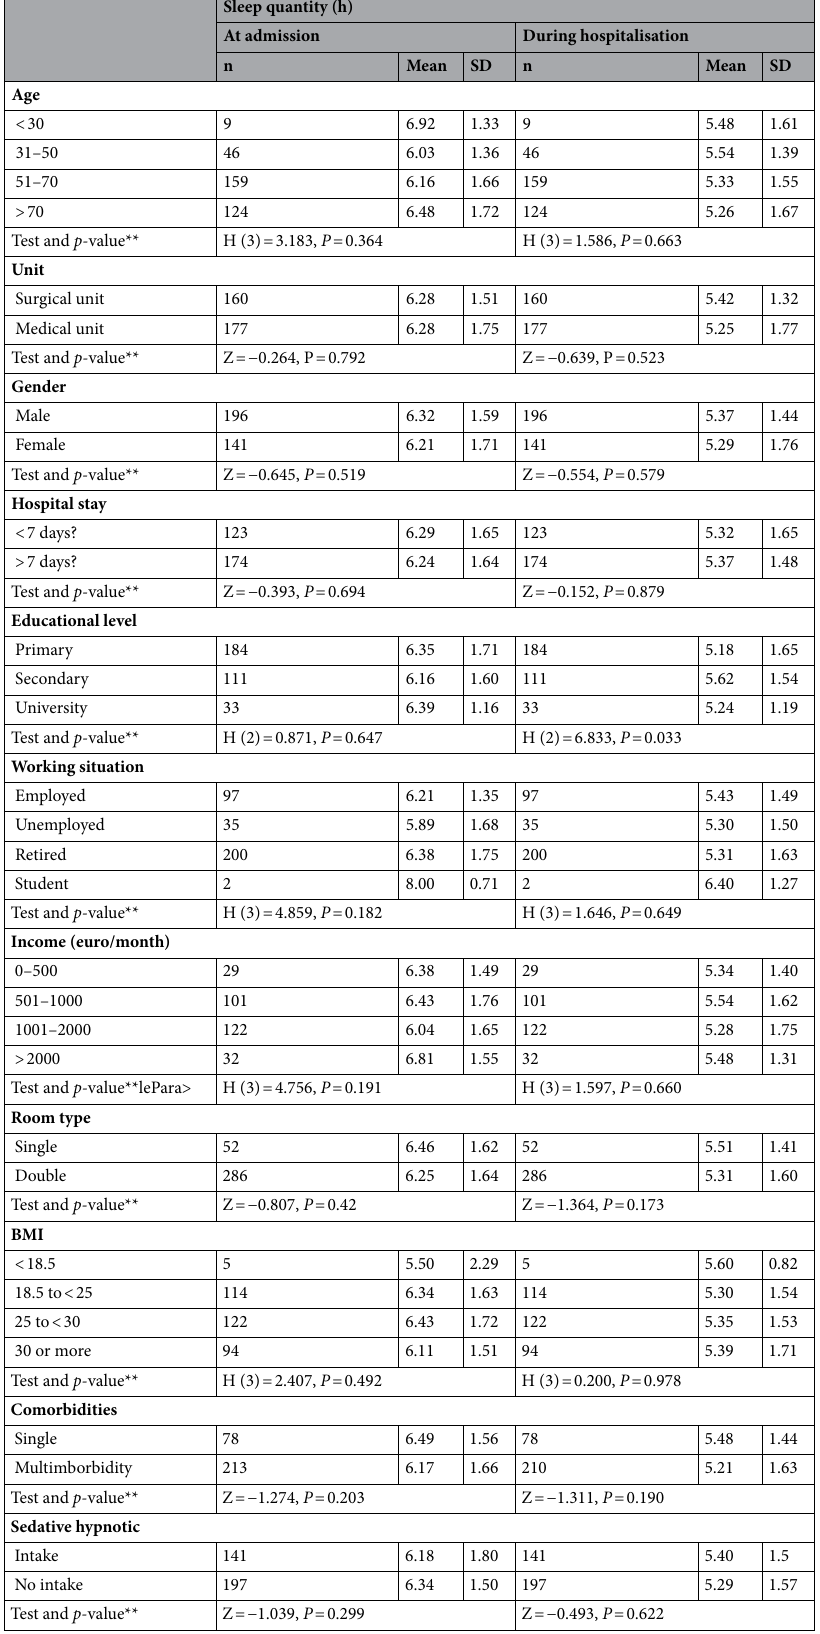
Table 4. Effects sleep quantity (in hours). **Student’s t test or